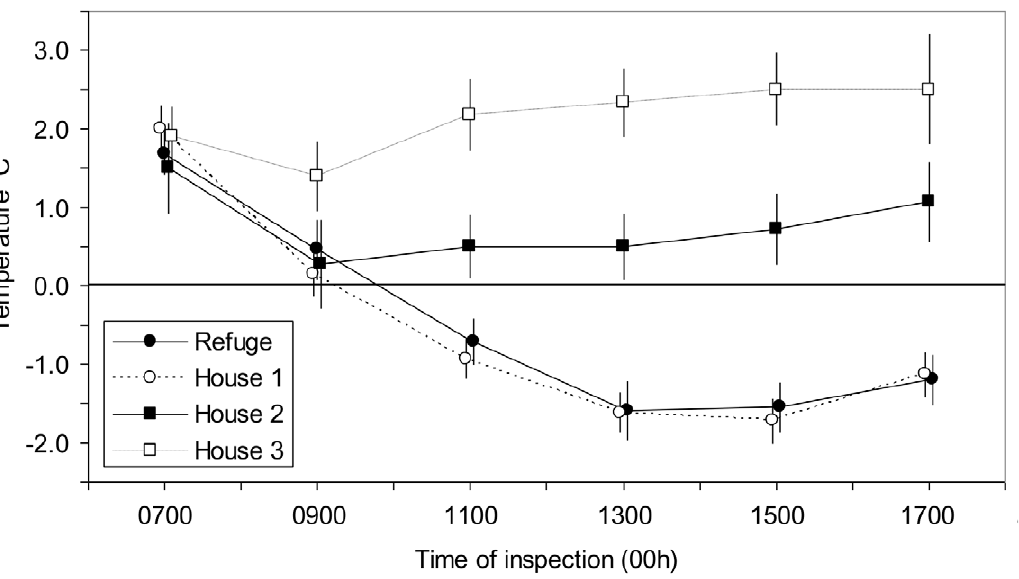
Figure 2. Temperature in a refuge and Houses 1–3 at various times of day. Temperature is expressed as the mean difference between the temperature in the refuge or house and the temperature in a Stevenson screen, so that if the difference is negative the temperature in the refuge or house was lower than in the screen. Vertical bars through the plots indicate the 95% confidence limits of the mean. Some plots are slightly displaced horizontally to ensure that the bars are not confused. Houses 1, 2 and 3 had roofs of thatch, asbestos and tin,